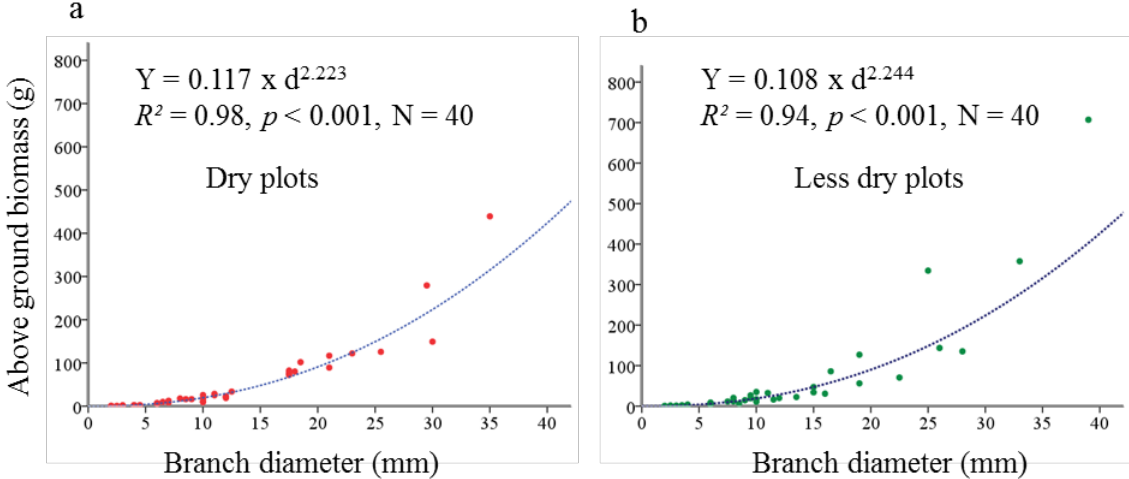
Figure 9. Regression model for biomass equation of the dry ( a ) and less dry plots ( b ). Biomass (Y) is modeled as the power function of stem/branch diameter (d). Biomass was measured in gram and diameter in millimeter (mm).